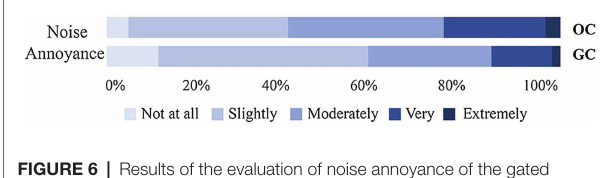
FIGURE 6 | Results of the evaluation of noise annoyance of the gated community and the open community. GC, the gated community and OC, the open